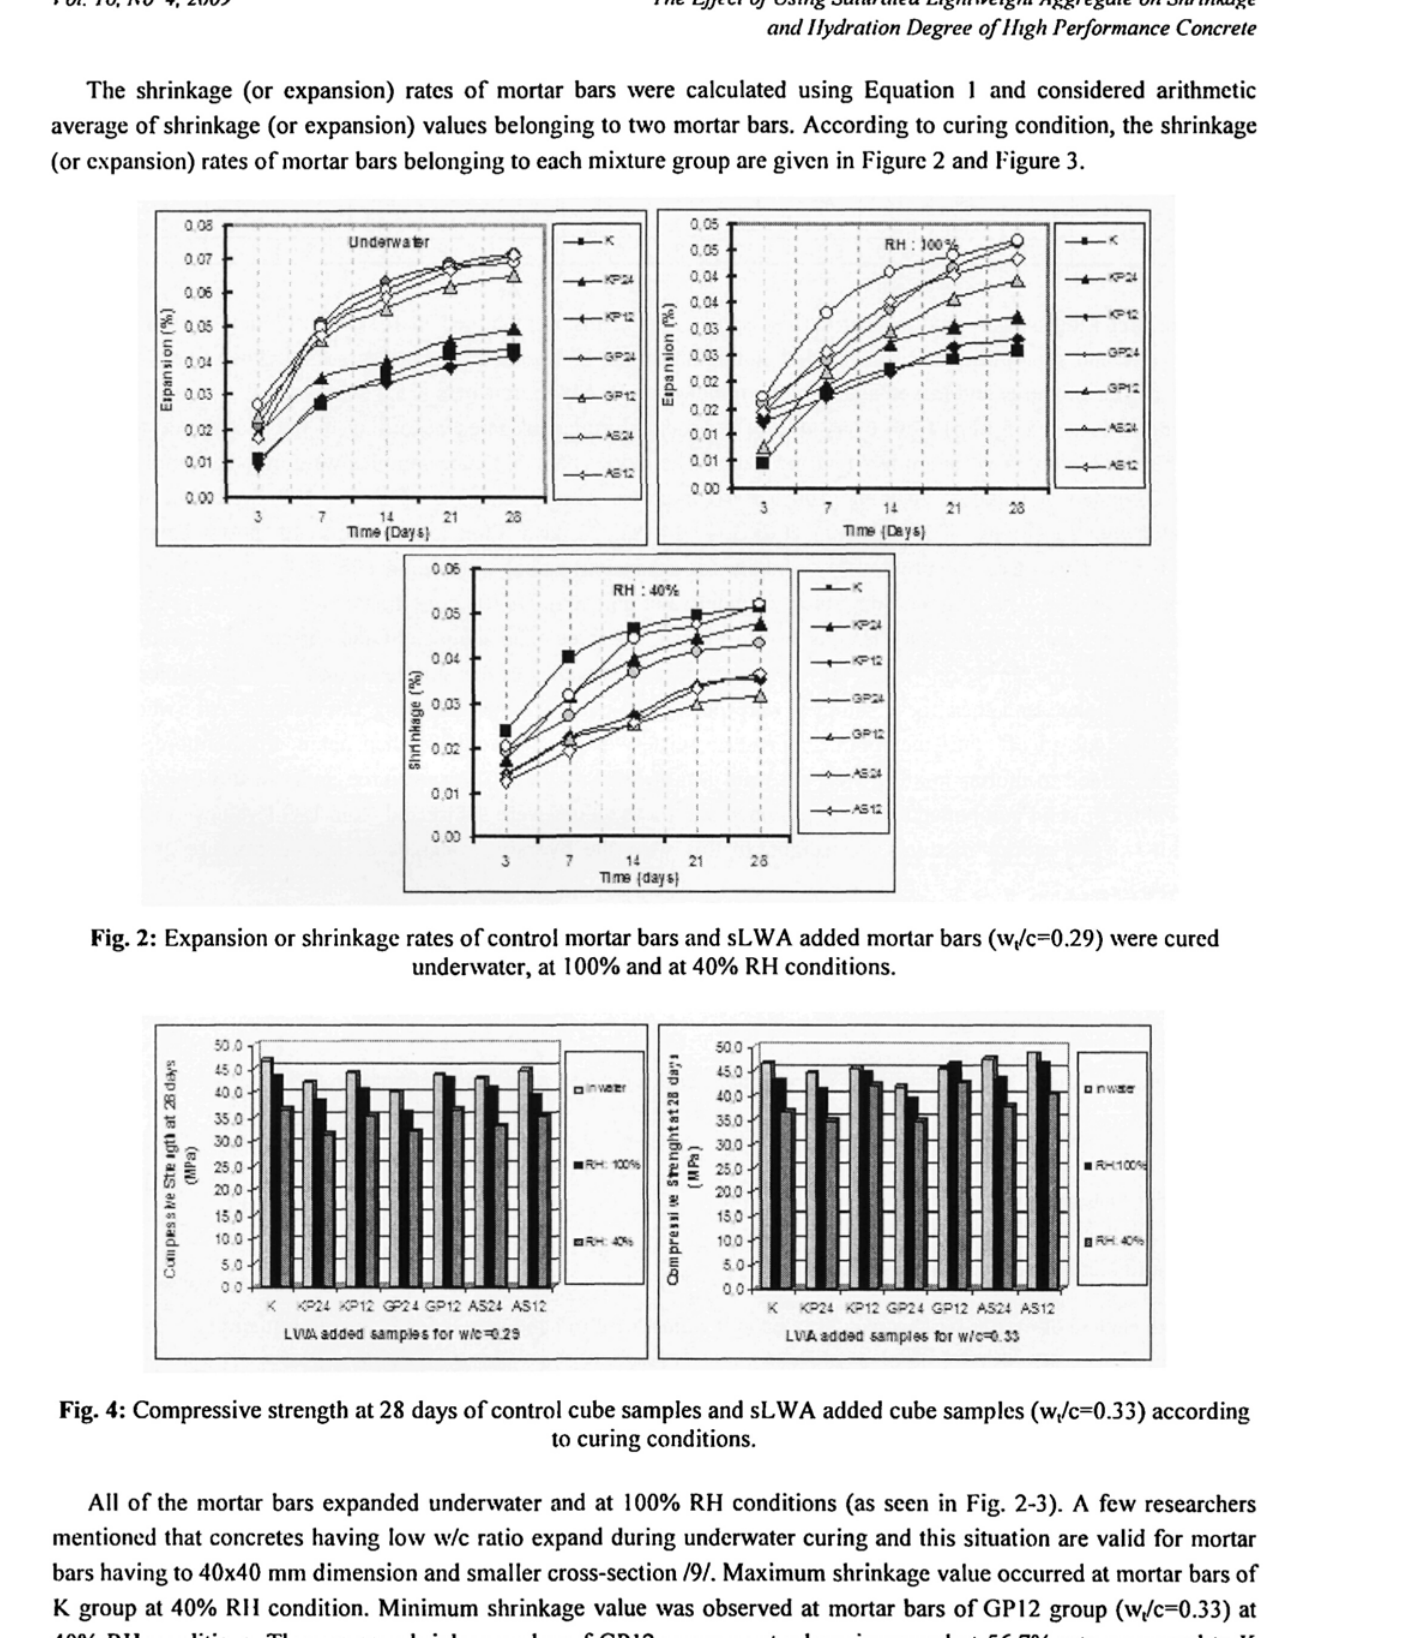
Fig. 4: Compressive strength at 28 days of control cube samples and sLWA added cube samples (w,/c=0.33) according to curing